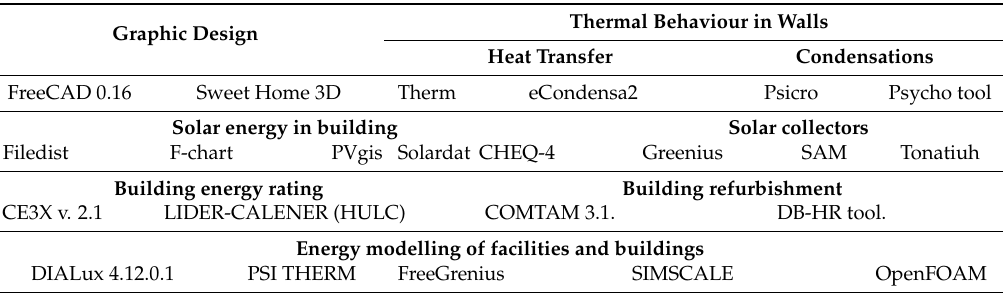
Table 1. Free software used in building